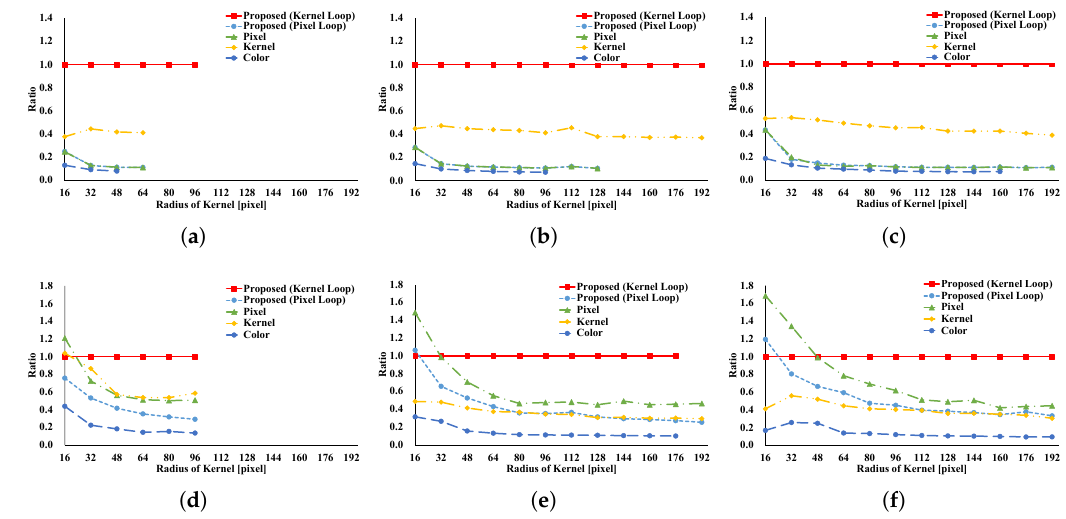
Figure 13. The speedup ratio for adaptive Gaussian filtering (AGF) with respect to kernel radius of FIR filtering. ( a ) Full sample in weight computation; ( b ) 1/4 subsample in weight computation; ( c ) 1/16 subsample in weight computation; ( d ) Full sample in LUT; ( e ) 1/4 subsample in LUT; ( f ) 1/16 subsample in LUT. If the ratio exceeds 1, this pattern is faster than the kernel loop